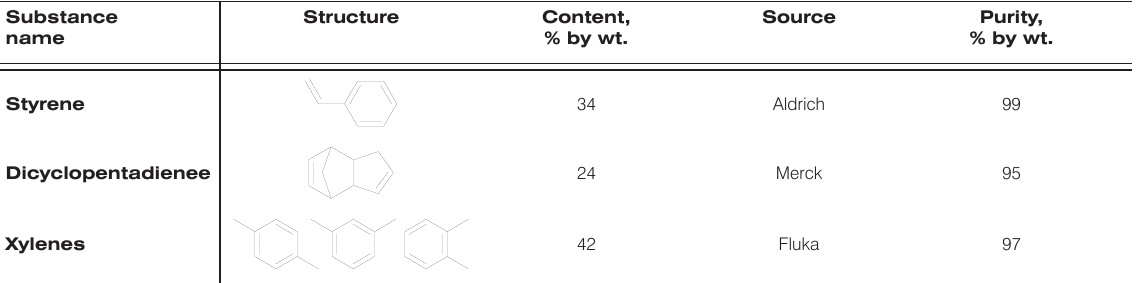
Table 1. The model mixture